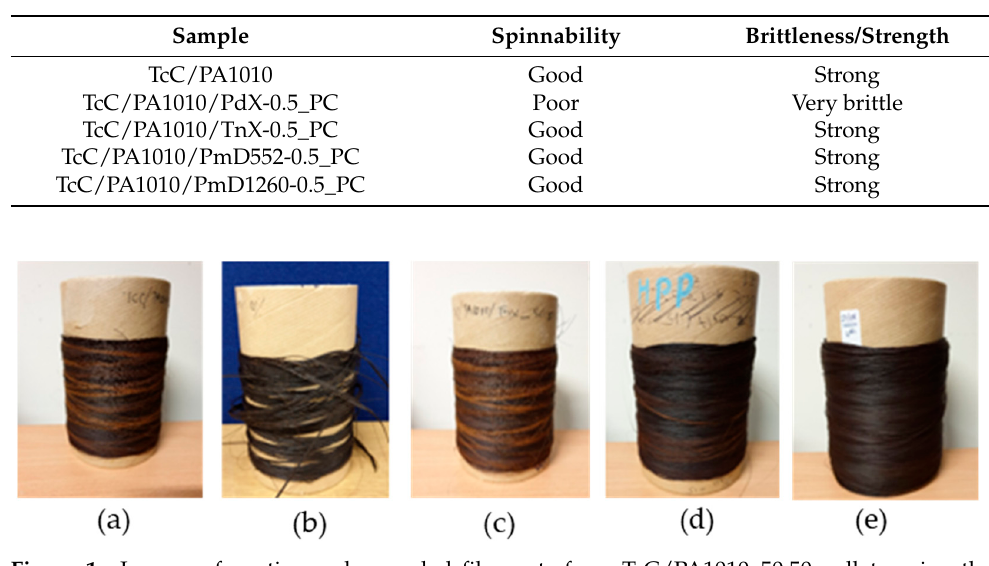
Figure 1. Images of continuously spooled filaments from TcC/PA1010_50:50 pellets using the pellet-coating method: ( a ) TcC/PA1010, ( b ) TcC/PA1010/PdX-0.5_PC, ( c ) TcC/PA1010/TnX-0.5_PC, ( d ) TcC/PA1010/PmD552-0.5_PC and ( e ) TcC/PA1010/PmD1260-0.5_PC.